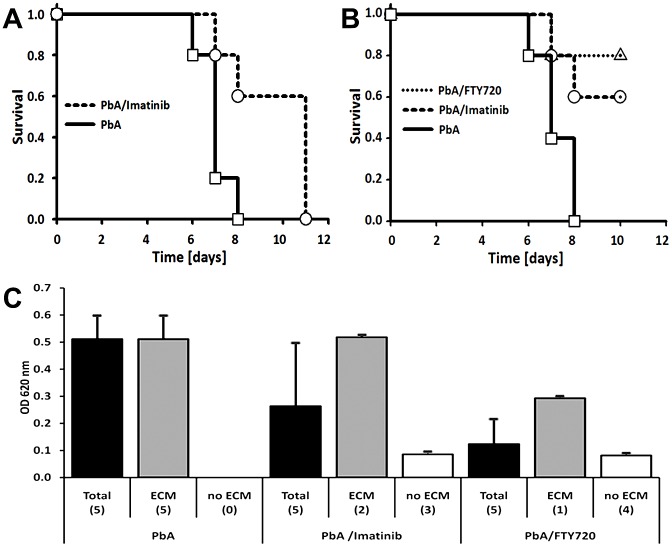
Vascular leakage is regulated and preventable.Groups of 5 PbA-infected CBA/CaJ mice received two daily oral doses of 250 mg/kg imatinib on days 5, 6, and 7 post infection, one daily oral dose of 0.3 mg/kg FTY720 starting one day before infection, or 3) no treatment. A) While all PbA-infected untreated mice died with clear neurological signs between day 6 and 8, survival of the imatinib-treated mice was significantly prolonged. B) Whereas all untreated PbA-infected mice died from ECM between day 6 and 8, imatinib and FTY720 treatment allowed 80% and 60%, respectively, of the mice to survive until day 10 at which time they were sacrificed for quantification of Evans blue in the brain. C) OD620 measurement revealed Evans blue leakage into the parenchyma of the untreated controls and the mice that succumbed to ECM despite treatment, but not the treated mice that survived until day 10. The data represent mean OD620 values ± STD. Brain hemispheres were analyzed individually.